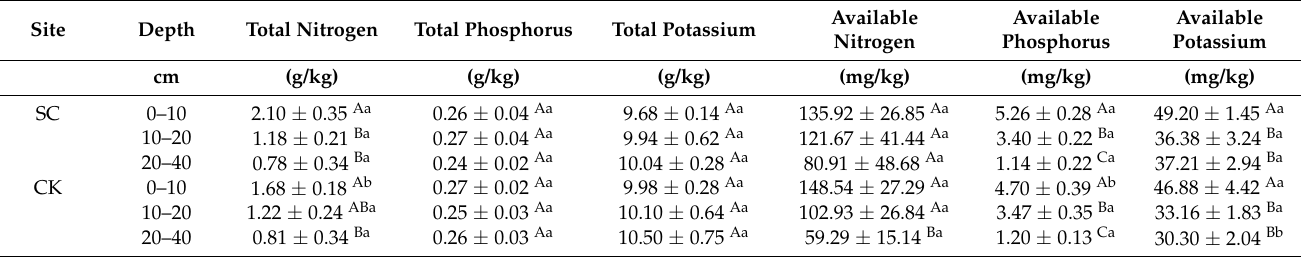
Table 2. Soil nutrients per sampling layer of the two study sites.